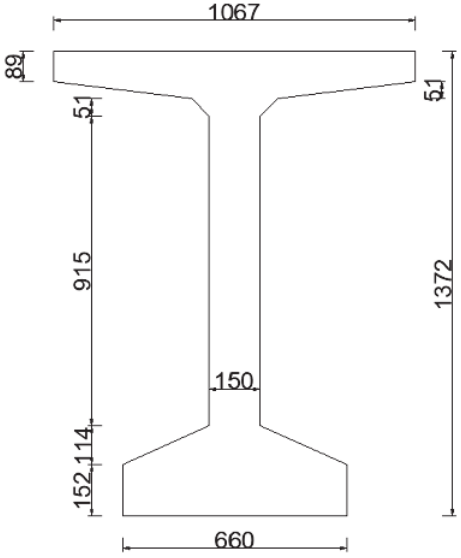
Figure 8 Beam section PCI BT-54 (dimensions in